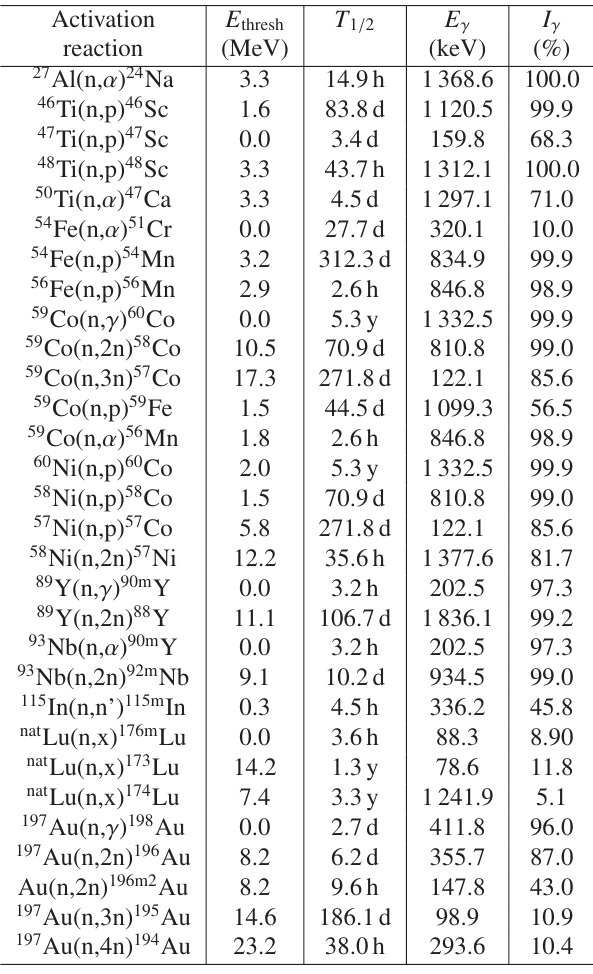
Table 1. Activation and threshold reactions observed in irradiation experiment and successfully used for neutron spectra deconvolution. [1,